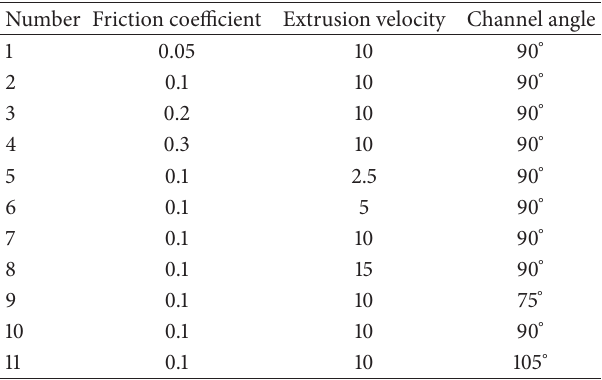
Table 1: The nominal value of friction coefficient, extrusion velocity, and channel angle.